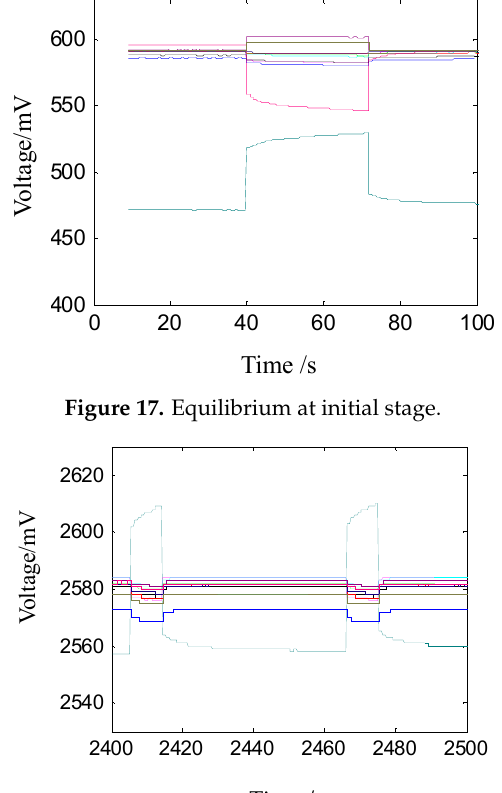
Figure 16. Voltage equalisation curves of the first battery module.